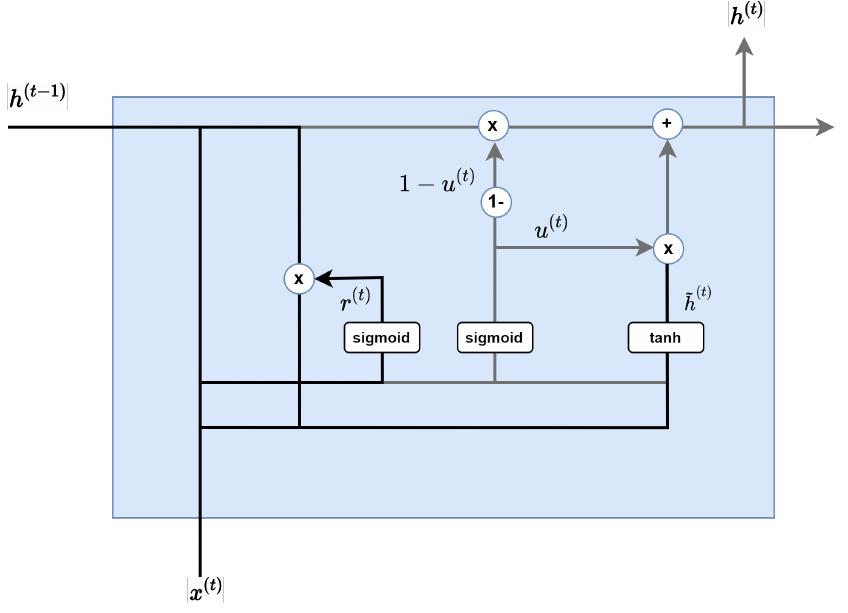
Figure 8. Candidate